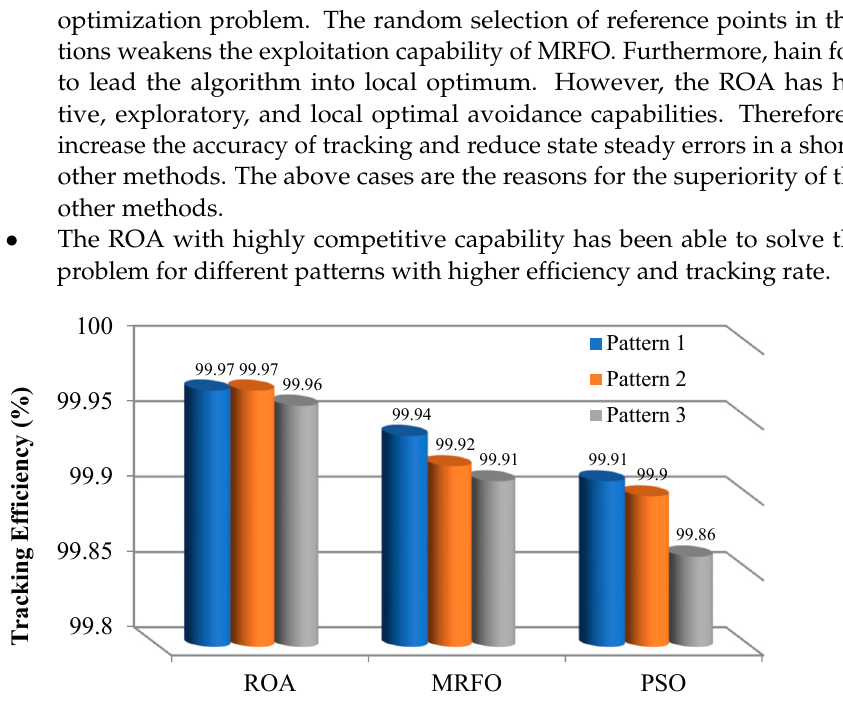
Figure 12. Results comparison in terms of tracking efficiency for different methods and patterns.